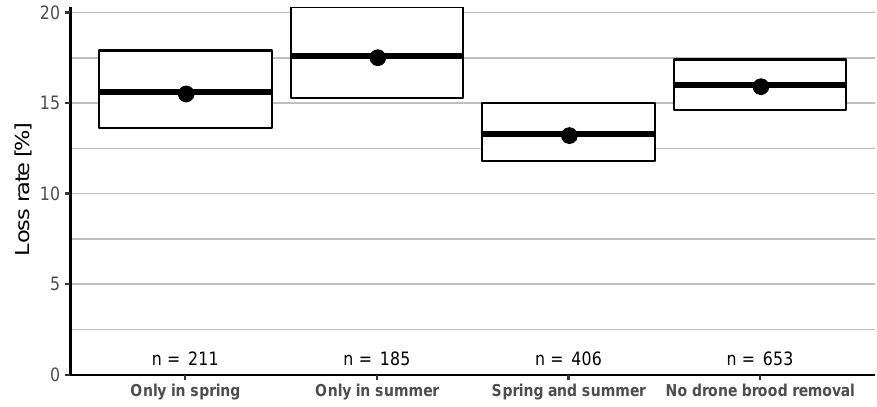
Figure 11. Winter honey bee colony loss rates (and 95% CI) in dependence of drone brood removal performed only in spring, only in summer, in spring and summer or not performed at